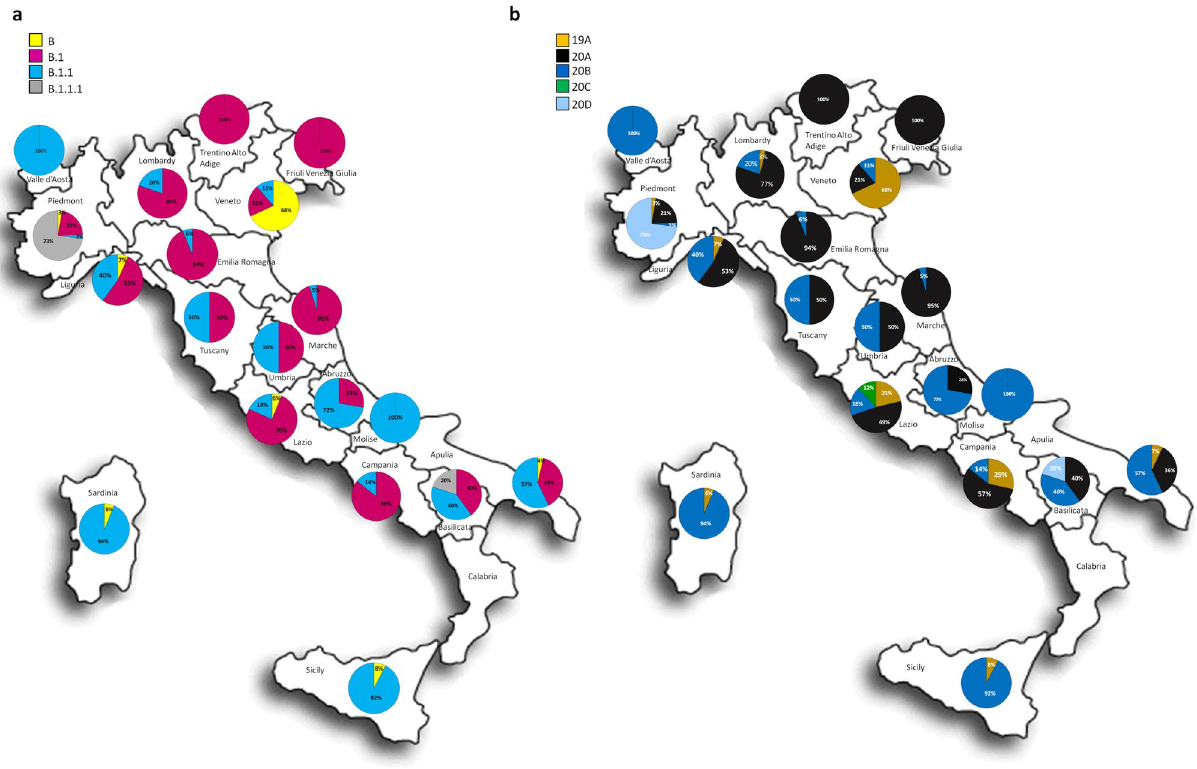
Figure 1. Spatial distribution of lineages and clades. ( a , b ) Map of Italy reporting the lineage distribution ( a ) and the clade assignment ( b ) in every